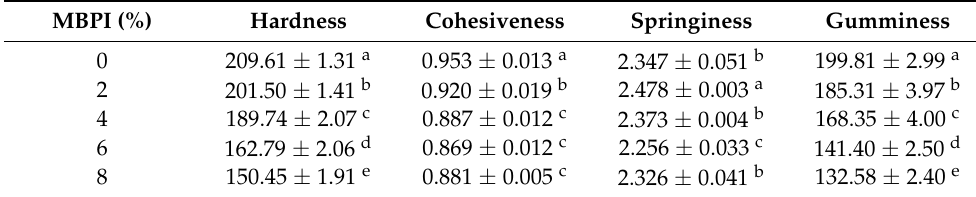
Table 1. Textural properties of NCS and NCS/MBPI gels at different MBPI